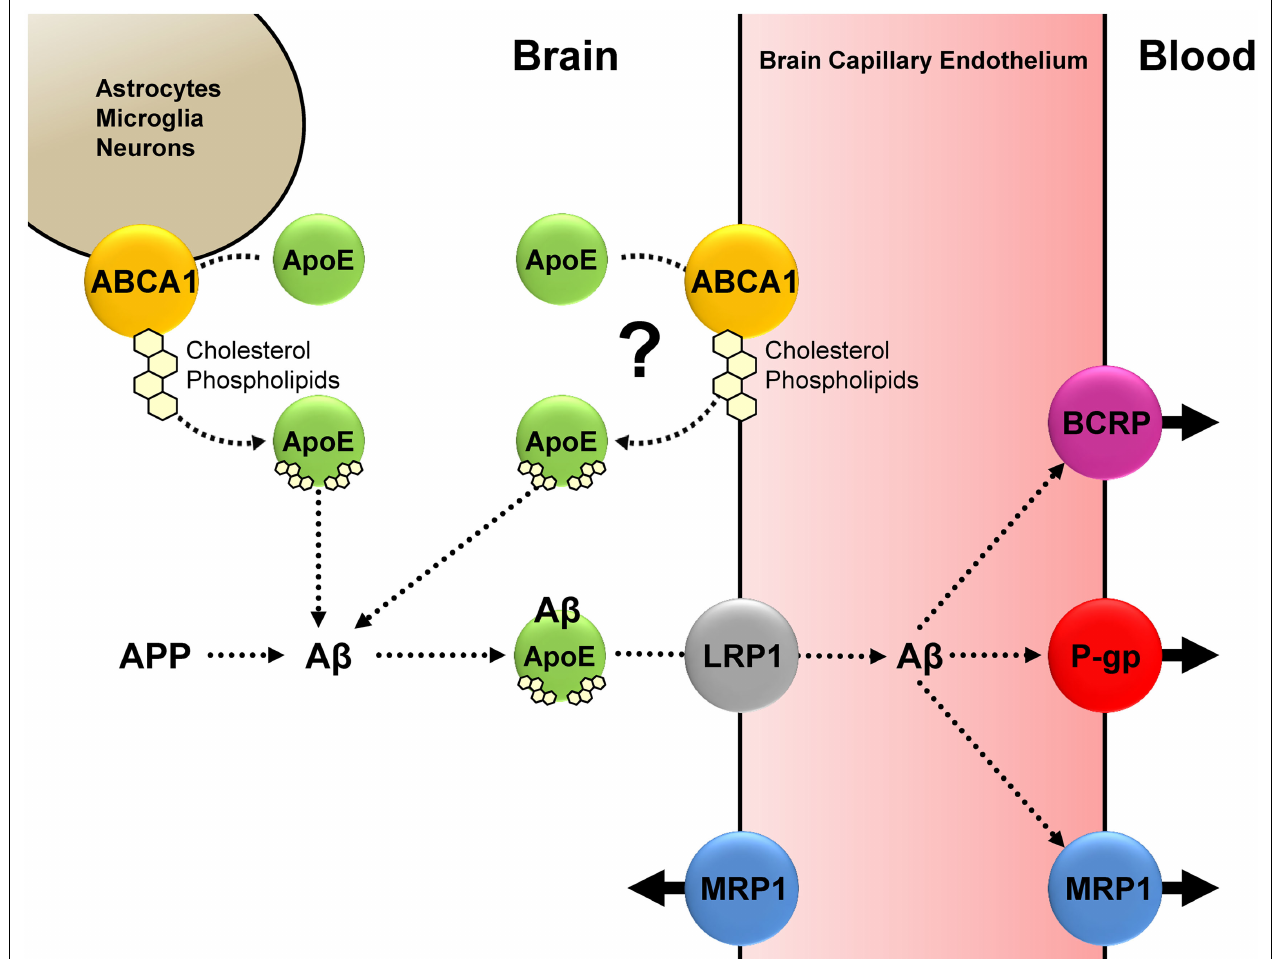
membrane of the brain capillary endothelium; this step is facilitated by LRP1. P-gp and MRP1 (and possibly BCRP) mediate A β efflux from the brain capillary endothelium into the blood.We postulate that a decrease in function of either ABCA1, LRP1, P-gp, or MRP1 (and possibly BCRP), or a decrease in function of some or all of these proteins reduces A β brain clearance, resulting in increased A β brain levels, which may pose a risk for